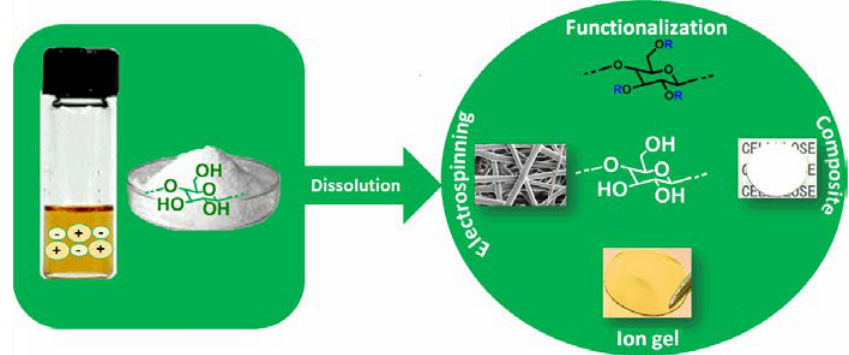
Figure 2. Possible materials and technologies generated from cellulose dissolved in ionic